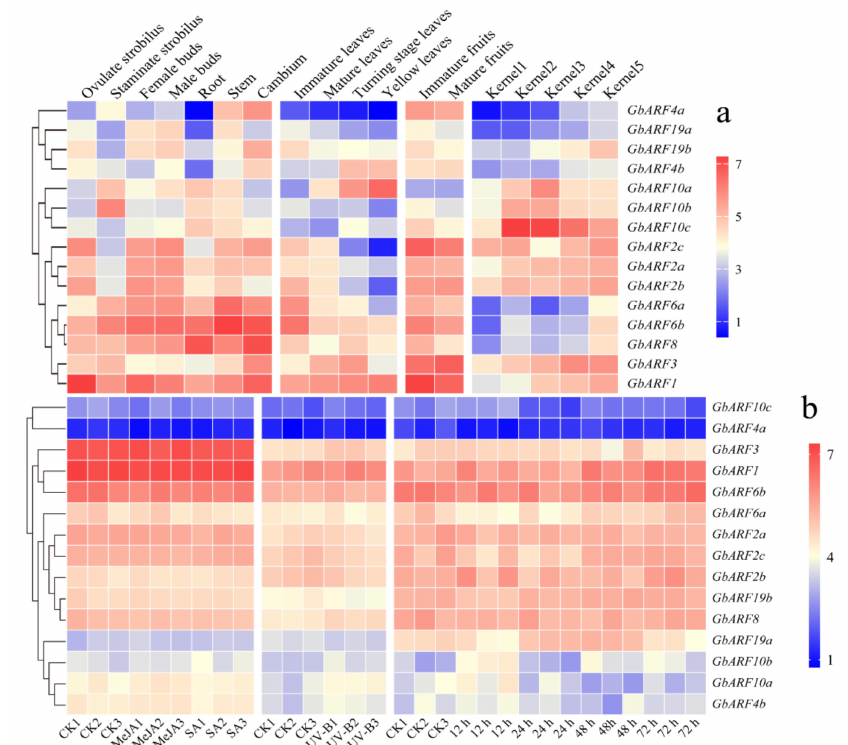
Figure 6. Expression profiles of GbARFs in different tissues, hormone induction and abiotic stress. ( a ) Tissue-specific expression of GbARFs . ( b ) Expression of GbARFs under hormone induction and abi- otic stress. The FPKM, transcript abundance was converted to log 2 (FPKM+1) to construct